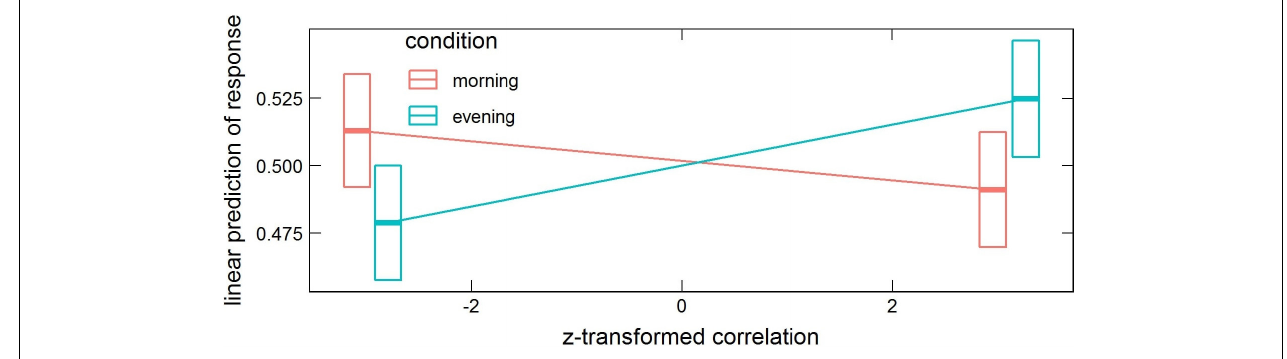
FIGURE 2 | Estimated means’ interaction condition × correlation in the global processing task, averaged over phase , probe and ROI levels. Horizontal bars are 95% CIs.